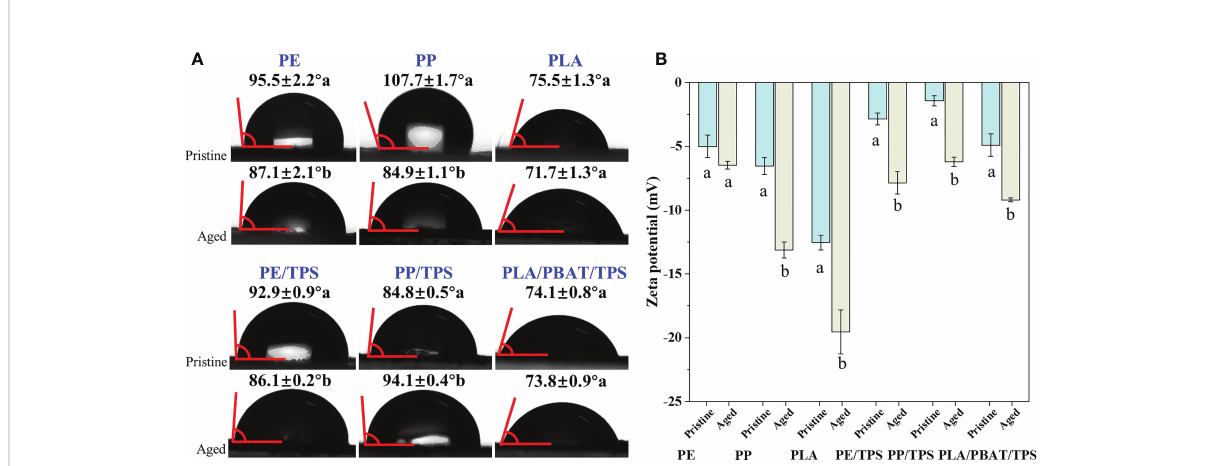
FIGURE 5 Contact angles (A) and zeta potentials (B) of the pristine and aged MPs treated by 2 months of UV irradiation in natural seawater. PE, polyethylene; PP, polypropylene; PLA, polylactic acid; PE/TPS, polyethylene/thermoplastic starch blends; PP/TPS, polypropylene/thermoplastic starch blends; and PLA/PBAT/TPS, polylactic acid/poly (butylene adipate- co -terephthalate)/thermoplastic starch blends. Different letters following the data or under each bar indicate signi fi cant differences between the pristine and aged MPs (Independent Samples t test; n = 3, P <